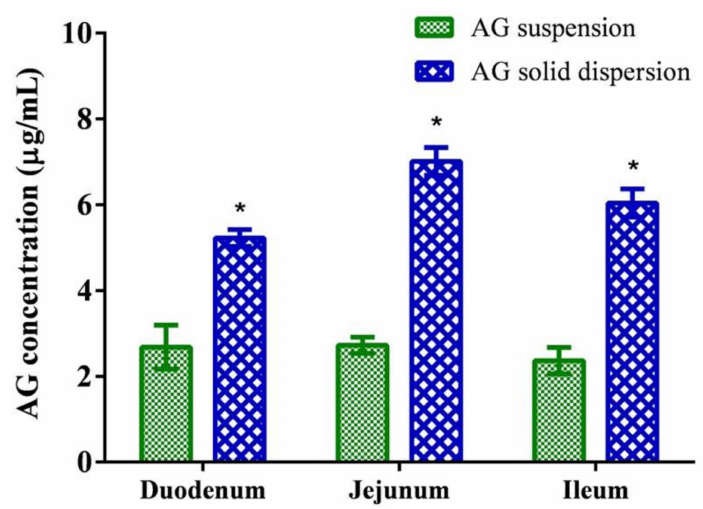
Figure 5. Permeability test of andrographolide (AG) suspension and optimized AG-loaded solid dispersion. Data are presented as mean ± standard deviation ( n = 3 for each group). * Indicates significant di ff erence compared to the AG suspension group ( p < 0.05).